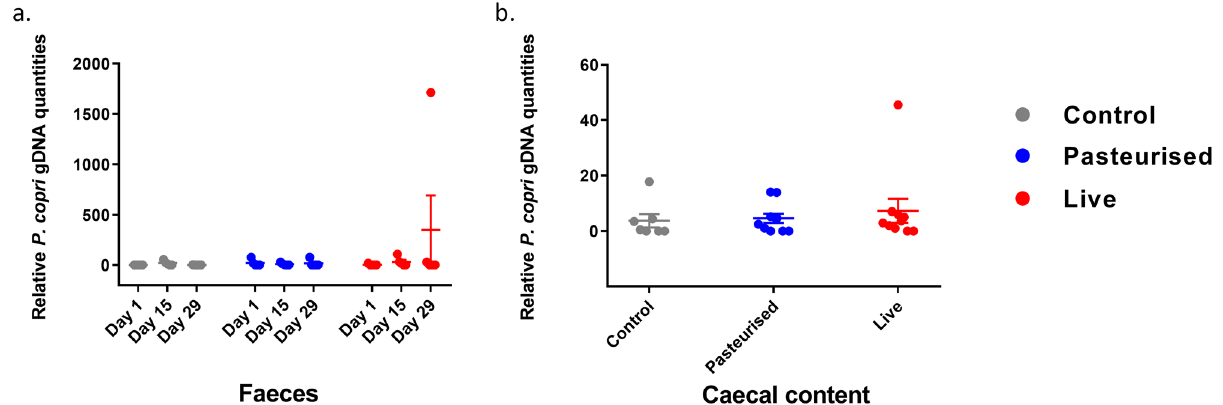
Figure 8. Colonisation assays. Relative genomic DNA content of P. copri in caecal content (left) and faeces (right) samples for three treatment groups. Pooled per cage of 2 mice for faeces (n = 5), for faecal content: n =